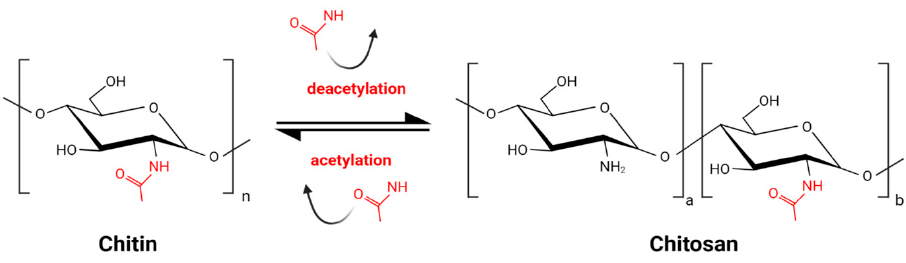
Figure 1. Schematic reaction of partial chitin deacetylation and obtaining chitosan.